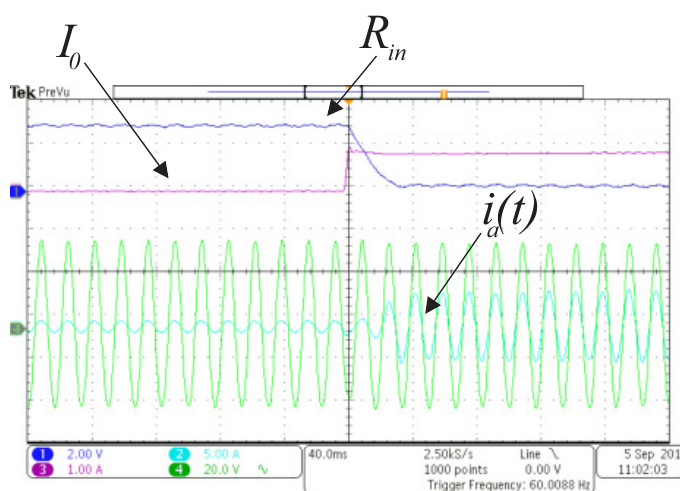
Figure 16. R in controller (5 Ω /V) (2 V/div), DC-link current (1 A/div), grid voltage (20 V/div) and phase current (5 A/div) for PWM rectifier transient from no-load to high-load. Hor. 40 ms/div.